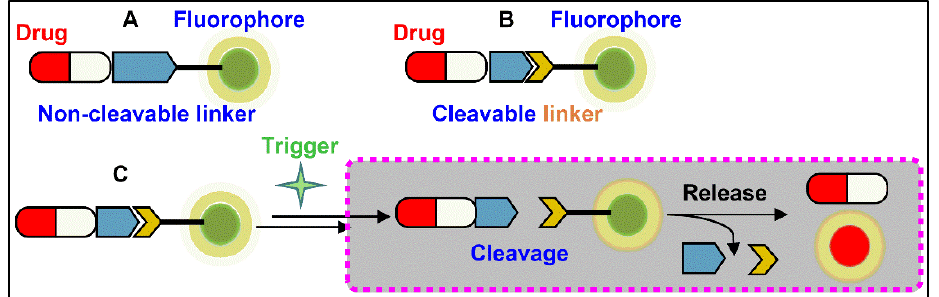
Figure 52. Schematic representation of two main types of fluorophore-drug conjugates: ( A ) non- cleavable conjugates; ( B ) cleavable conjugates; ( C ) Design principle of fluorogenic and release-based cleavable conjugates [24].